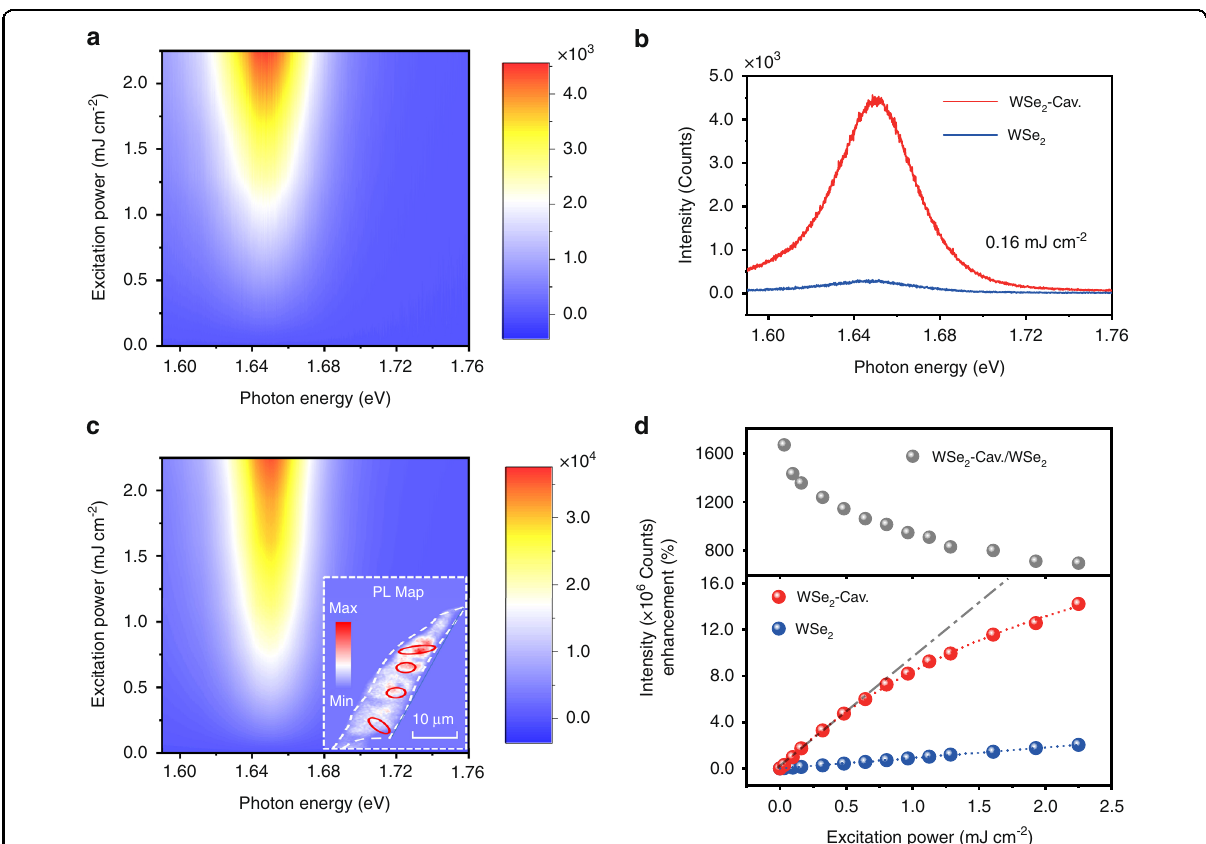
Fig. 3 Upconversion ampli fi ed by the plasmonic cavity. a Excitation power-dependent upconverted emission spectra for monolayer WSe 2 on SiO 2 /Si. b Enhanced upconverted emission spectra of monolayer WSe 2 in the designed plasmonic cavity at an excitation power of 0.16 mJ/cm 2 . c Excitation power-dependent upconverted emission spectra for monolayer WSe 2 in the designed plasmonic cavity. Inset: PL map of the plasmonic nanocavity effect on exciton emission, where the nanocubes and monolayer WSe 2 are marked by a red solid line and white dashed line. d Excitation power-dependent integrated upconverted emission intensity (down) and enhancement (top) for monolayer WSe 2 in the designed plasmonic cavity. The experimental results (scattering points) can be fi tted well by the blue and red dotted lines based on Eq.